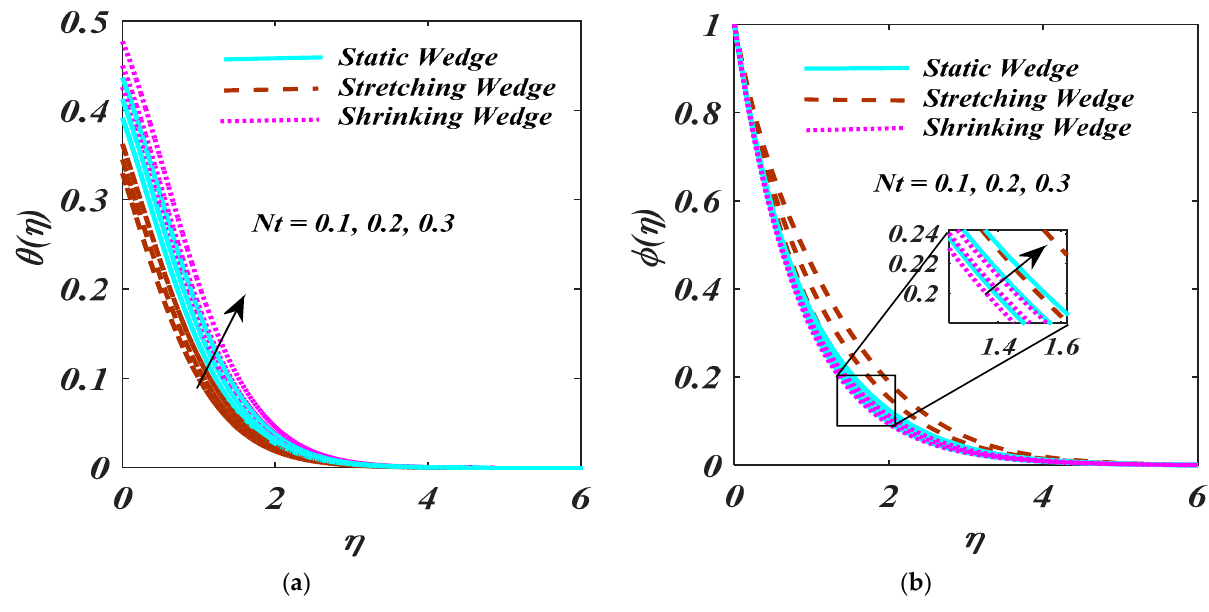
Figure 7. ( a , b ) θ ( η ) and φ ( η ) impact on Nt . Figure 8a,b reports the high values of Nb and Nt for θ ( η ) and φ ( η ) . The temperature field θ ( η ) is upswing due to larger Nb . Betterment of temperature profile due to the prominent between particle motion produces extra heat with the Nb upgrades. The higher magnitude of Nt causesfor the growth of nanoparticle concentration. It is interpreted that the higher the magnitude of the Nt , the extra particles are moved far from the hotter region which boosts the increment of nanoparticles concentration.